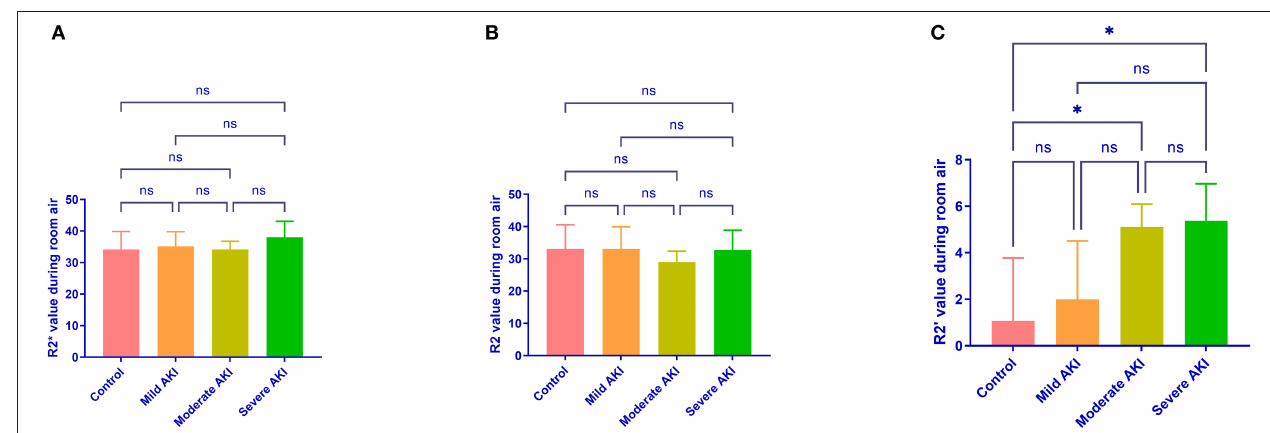
FIGURE 4 | R2*, R2, and R2’ values during room air in different groups. R2* (A) and R2 (B) values during room air are similar among different groups. R2’ (C) values were greater in moderate ( P = 0.032) and severe ( P = 0.022) AKI groups than in control groups. * P < 0.05; ns, not significant.